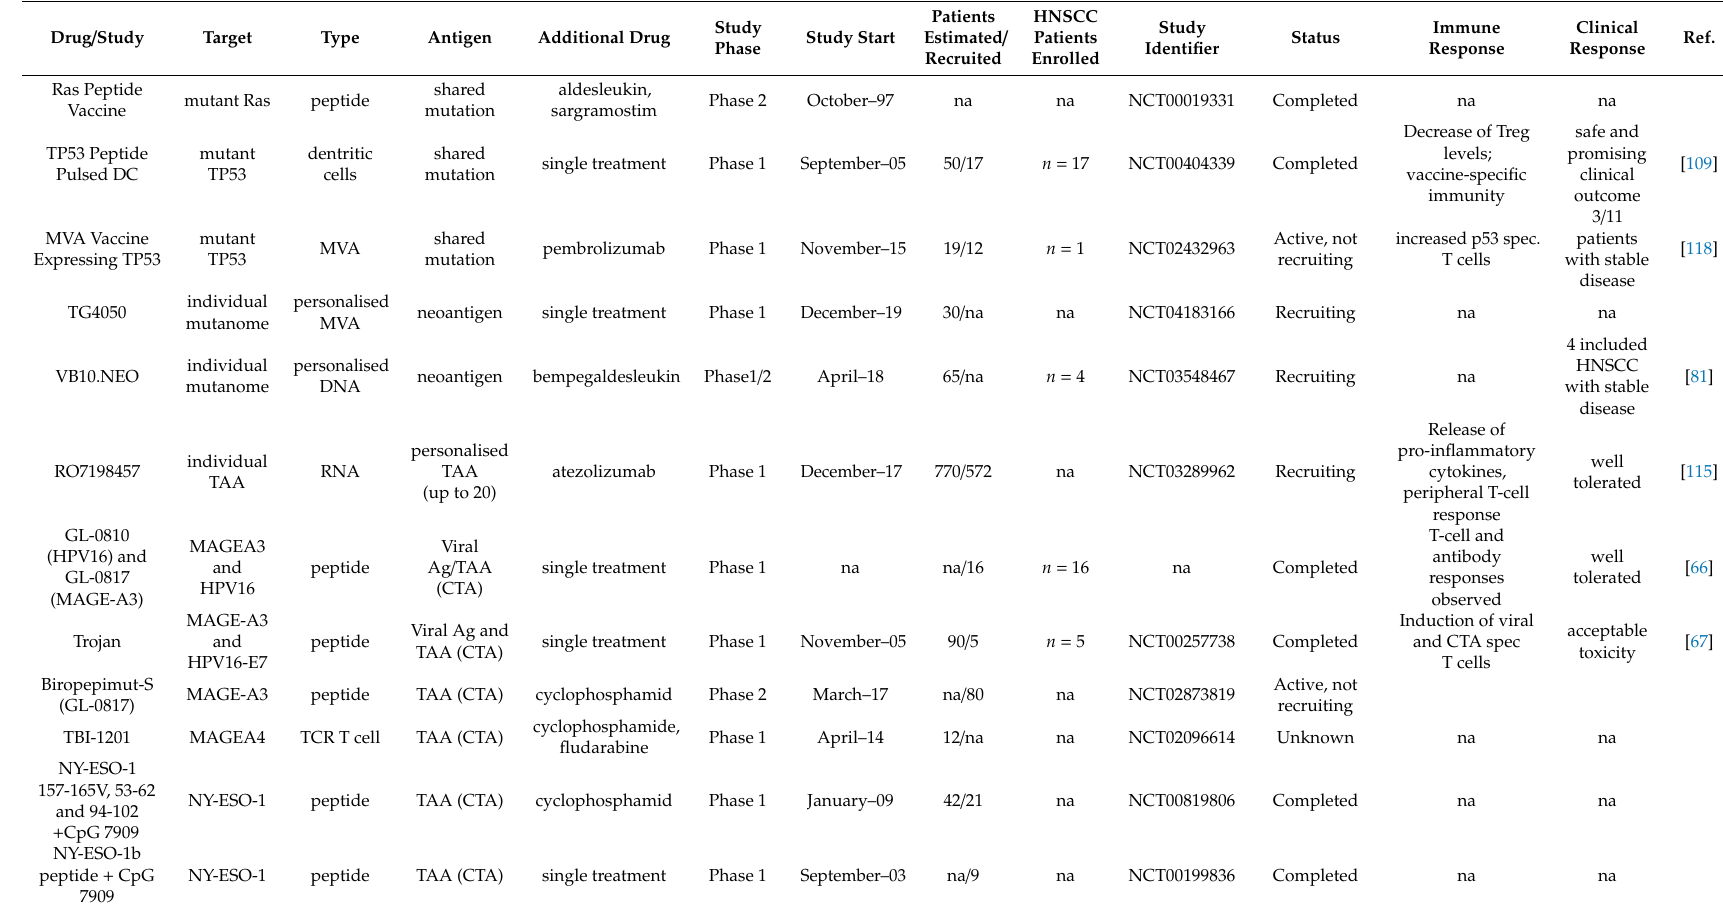
Table 2. Overview of completed and ongoing clinical trials targeting tumour antigens in HNSCC